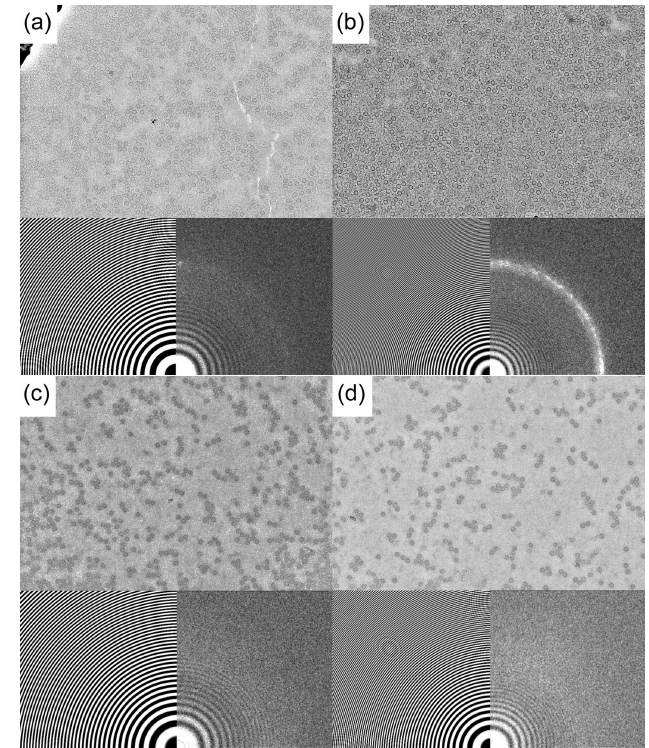
Figure 2 Sample real space detector images and corresponding image CTFs and FFTs of 5 mg ml (cid:3) 1 apoferritin solutions that were dispensed and blotted on ( a ) and ( b ) a Quantifoil UltraAuFoil grid (sample 1) and ( c ) and ( d ) a prototype grid (sample 2), both having gold foils with 1.2 m m holes, and then plunge-cooled in boiling LN 2 . Sample film thicknesses and areal particle densities were typically larger for sample 1 than sample 2. The majority of hole images and FFTs for sample 1 showed evidence of small amounts of crystalline ice, whereas nearly all hole images for sample 2 were fully